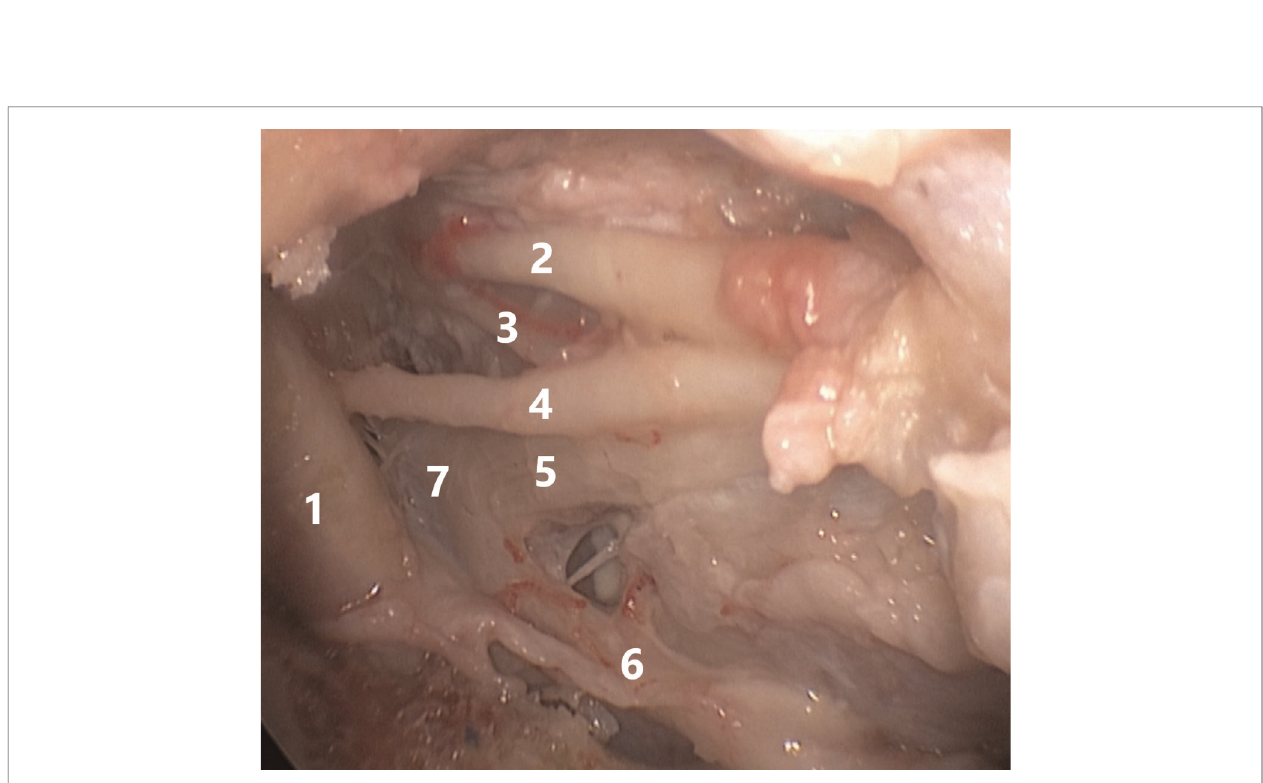
FIGURE 2 | Relationship between the structures of the cavernous sinus and the Gasser node: 1 — internal carotid artery, 2 — oculomotor nerve, 3 — trochlear nerve, 4 — abducens nerve, 5 — ophthalmic nerve, 6 — maxillary nerve, 7 — Gasser node.